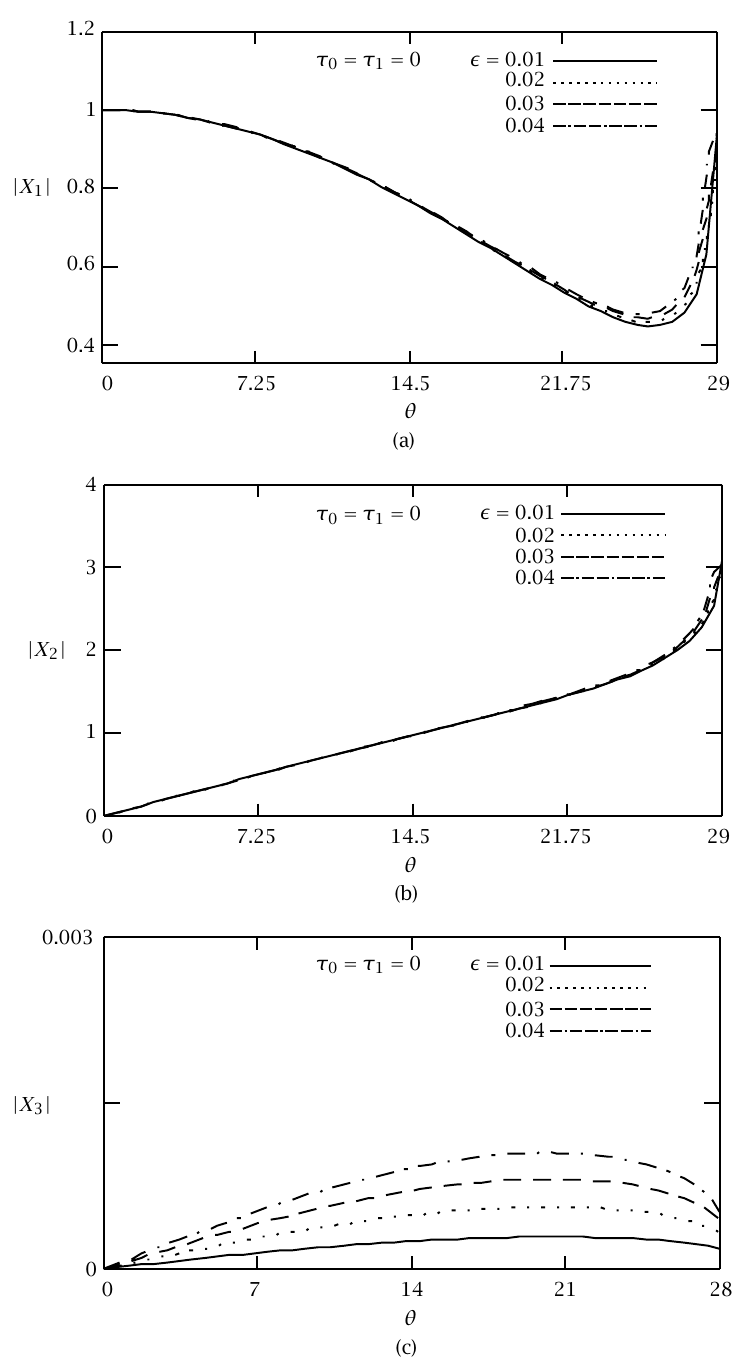
Figure 9 . (The thermal effect in C-D theory) | X 1 | , | X 2 | , | X 3 | versus the angle of incidence θ